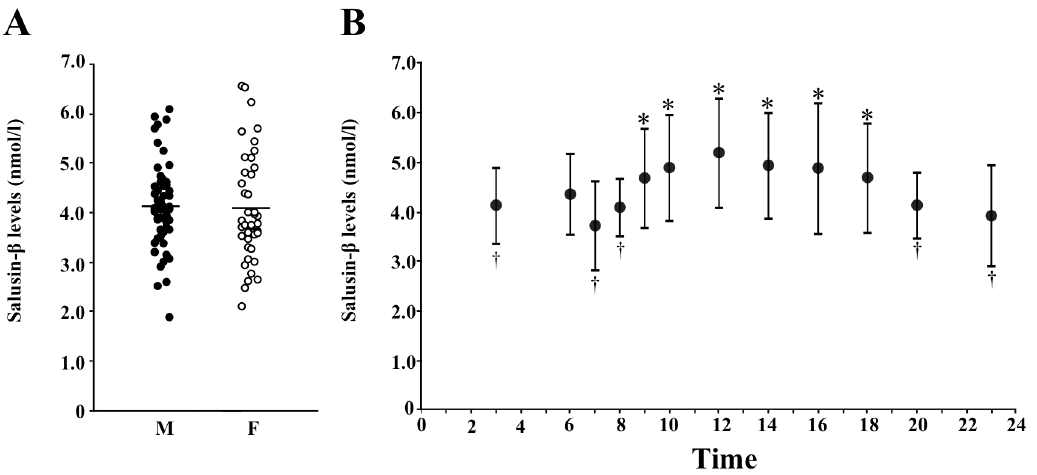
Figure 3. Plasma salusin-β concentrations and circadian changes in healthy volunteers. A . Distribution of plasma salusin-β levels obtained between 8 am and 11 am at ambulatory conditions from 106 healthy volunteers. Each point represents the salusin-β concentration found in a single subject and the horizontal bars indicate the mean salusin-β concentration for healthy males (M) and females (F). B . Circadian changes in mean ± SD plasma salusin-β levels in healthy subjects. * P < 0.05 vs. values at 7 am. † P < 0.05 vs. values at 12 noon.